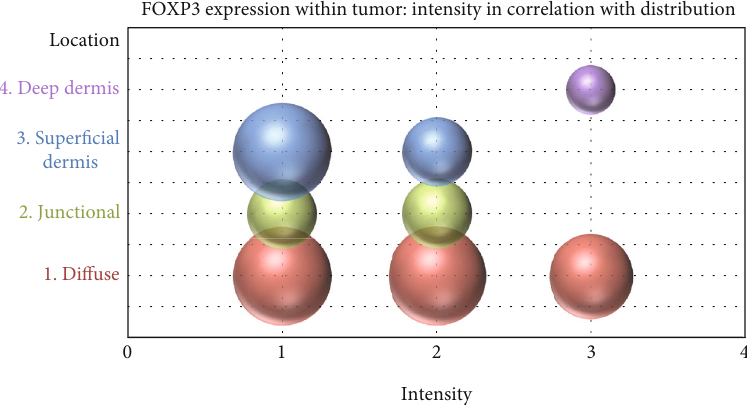
Figure 8: Correlation of FOXP3 intensity in tumor cells with the distribution of FOXP3-positive cells.